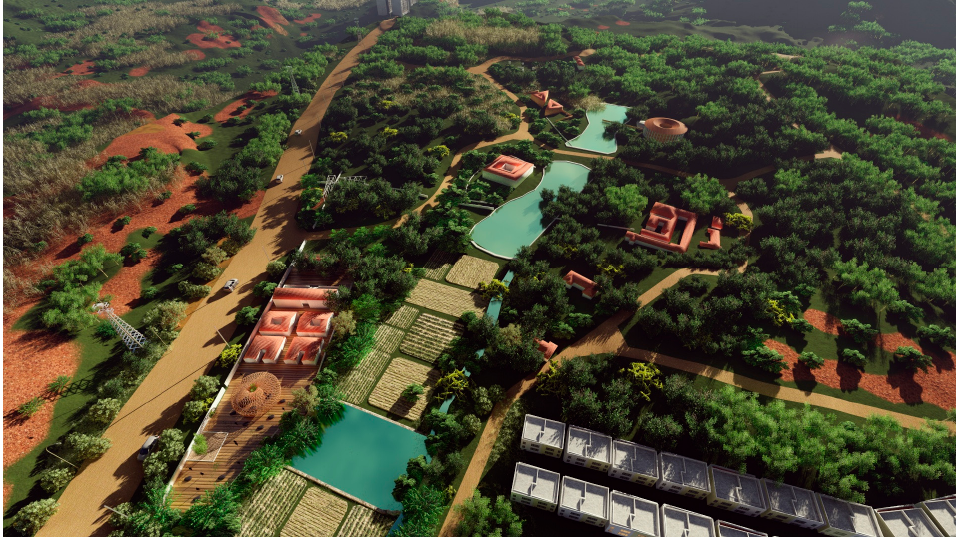
Figure 6. Aerial view of the village, by Francesco Grugni for China Lab.